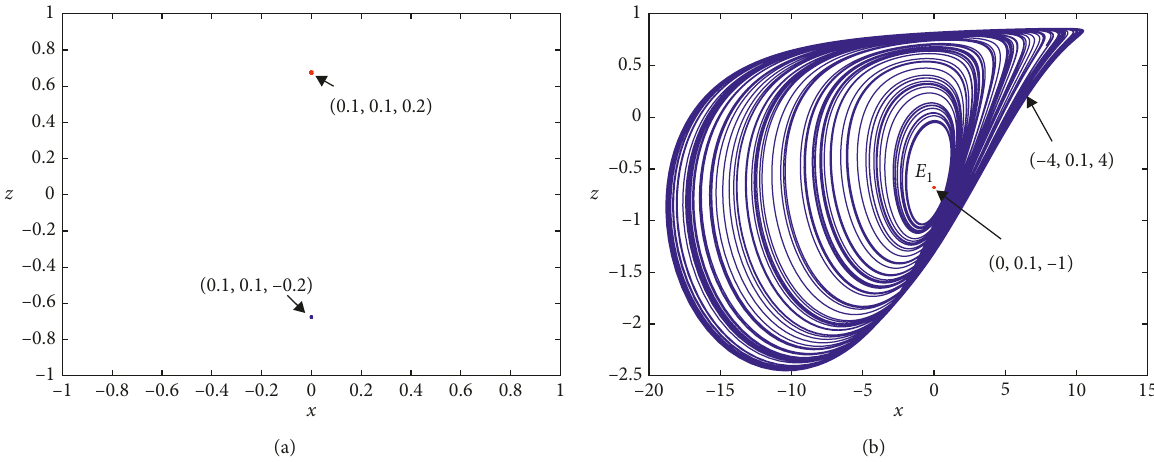
Figure 9: Bistability behaviors obtained in Simulink of MATLAB, the running time t � 100s. (a) α � 0.75, two sets of the initial values (0.1, 0.1, 0.2) and (0.1, 0.1, − 0.2); (b) α � 0.99, two sets of the initial values ( − 4, 0.1, 4) and (0, 0.1, −